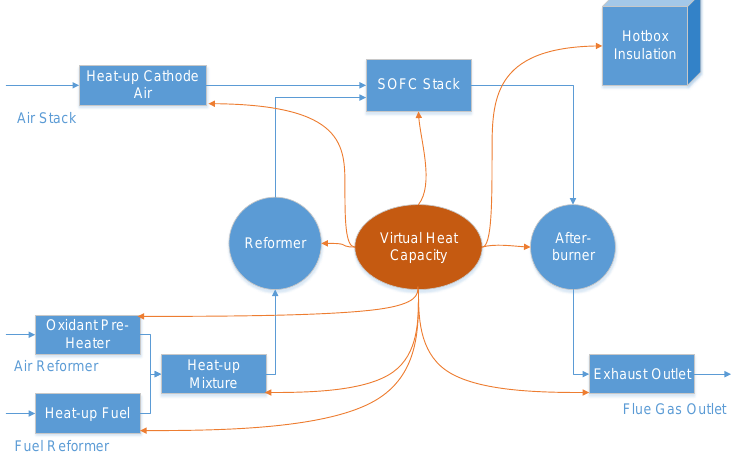
Figure 9. Schematic representation of the hotbox capacity model with the virtual heat capacity. The thermal coupling is orange-colored, and the fluidic coupling is blue-colored.